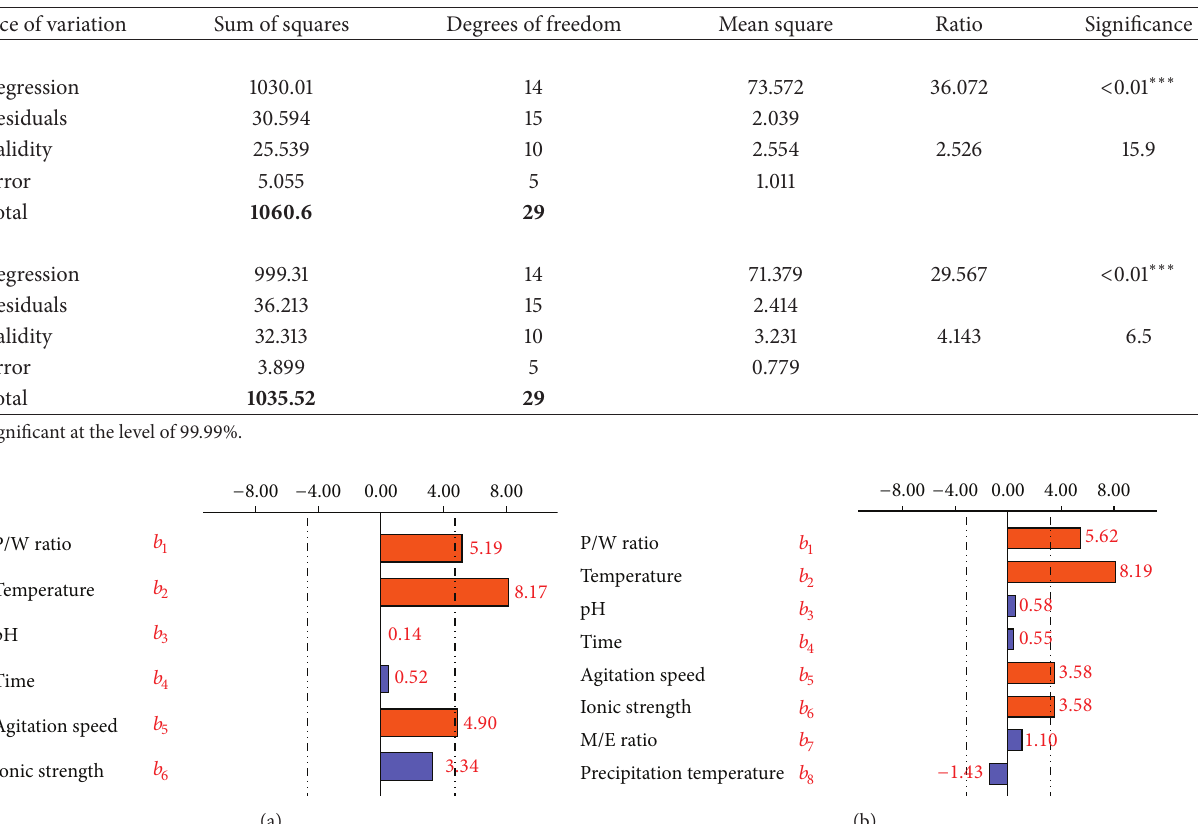
Table 8: Analysis of variance for Box-Behnken design.